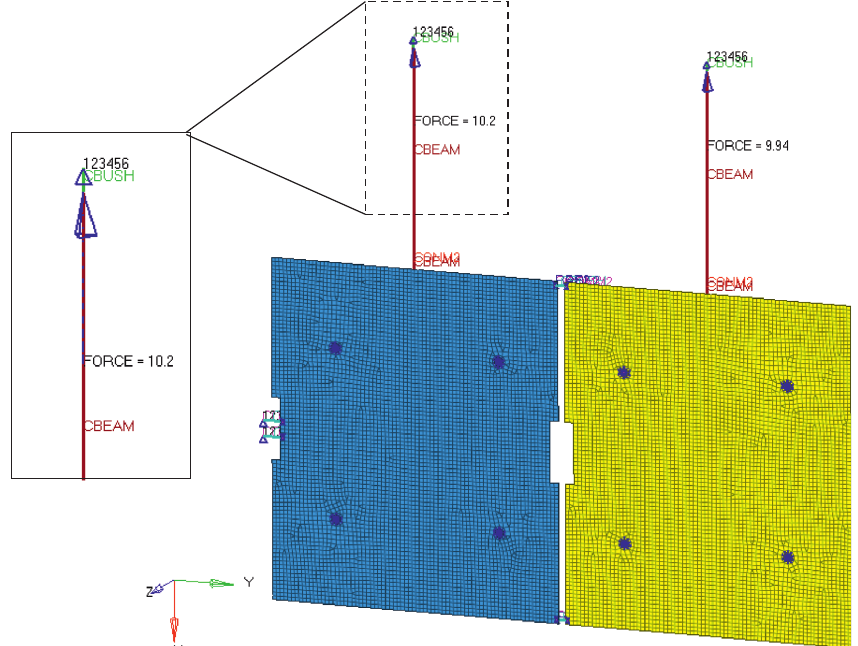
Figure 8: Finite element model of the test system. Table 2: Natural frequencies of the twofold solar array in the horizontal